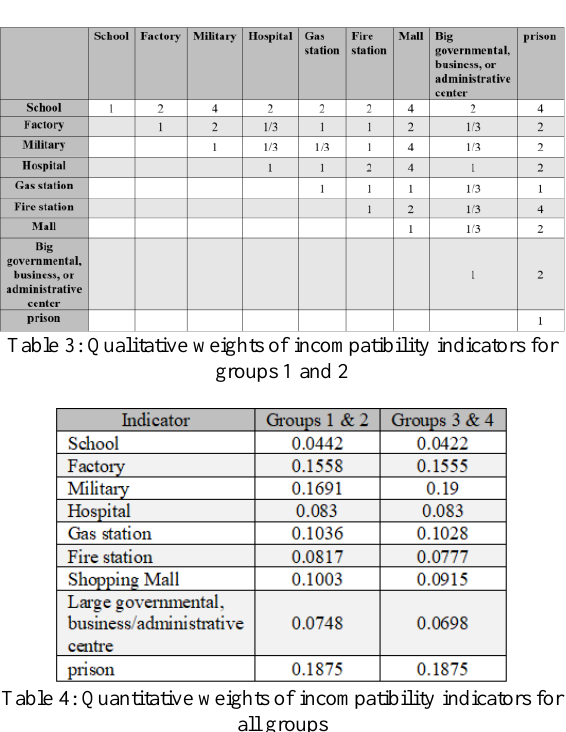
Figure 4: Dependency sub-criterion for group 1